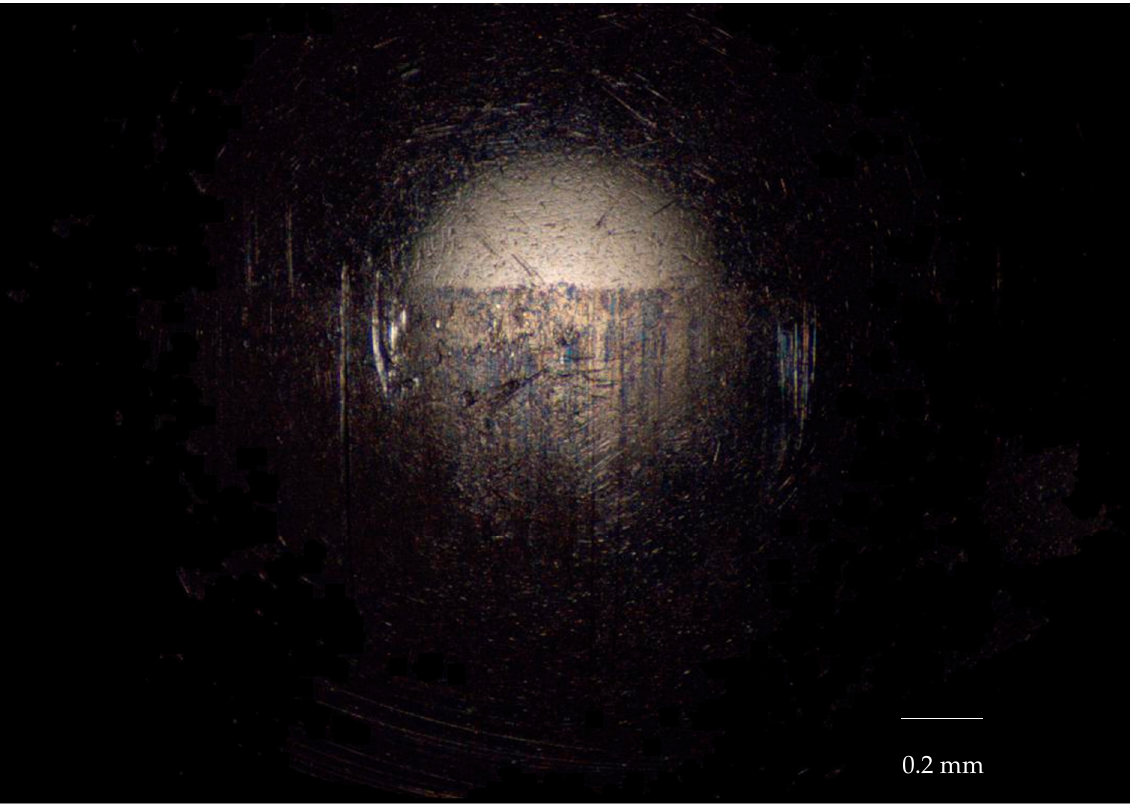
Figure 18. Indenter for test 4, showing no transferred material from the steel sample to the indenter.